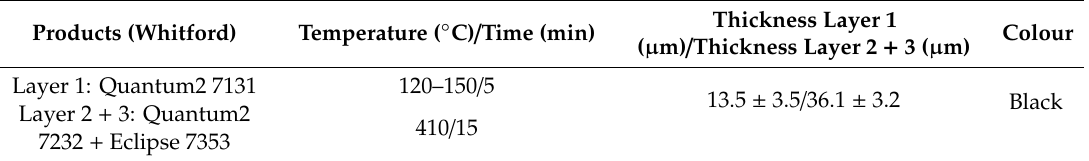
Table 2. Application process, thickness, and colour of PTFE coating TFI-2531 N.